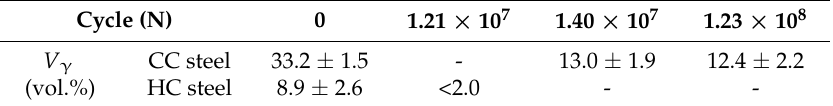
Figure 7. XRD patterns of contact surface of the two steels after RCF testing. Table 3. The V γ in the contact surface of the two steels after different RCF testing cycles.